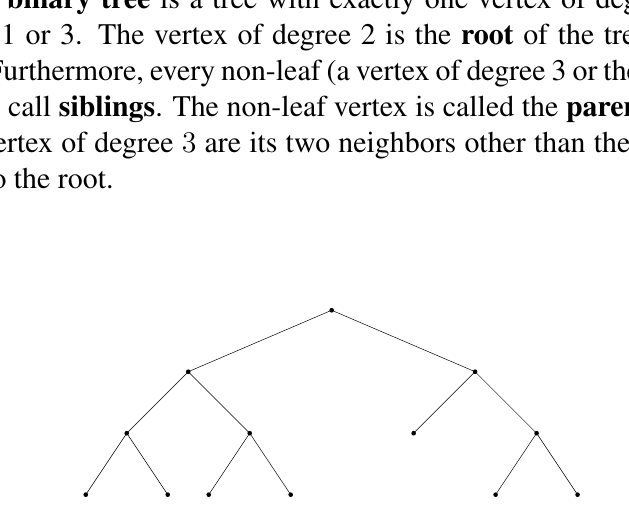
Figure 1: A full binary tree with 7